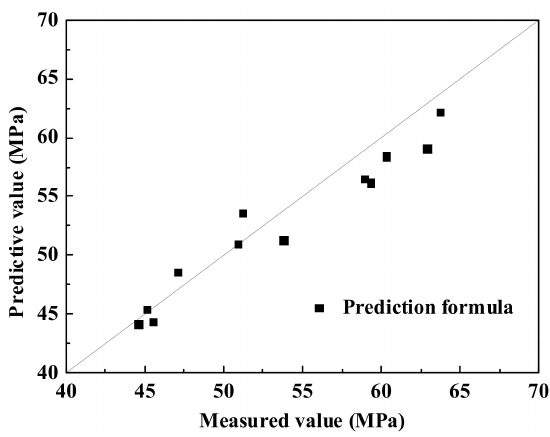
Figure 10. Comparison between predicted and measured compressive strength of GRLC